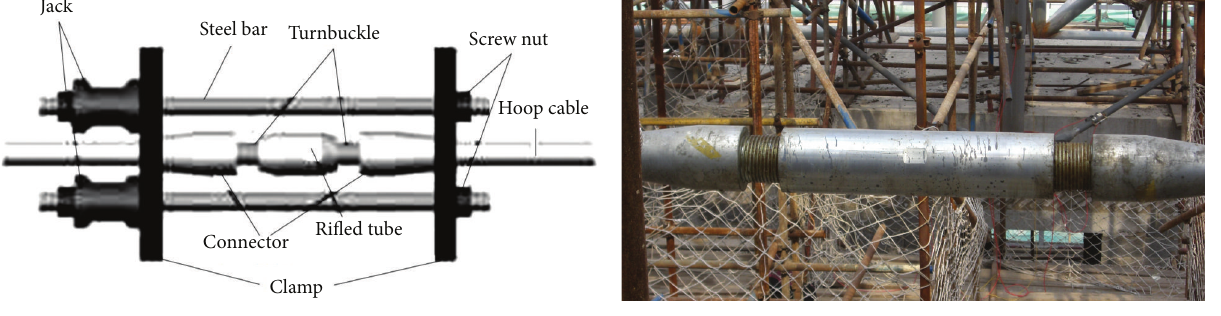
Figure 2: Tensioning points on hoop cables.